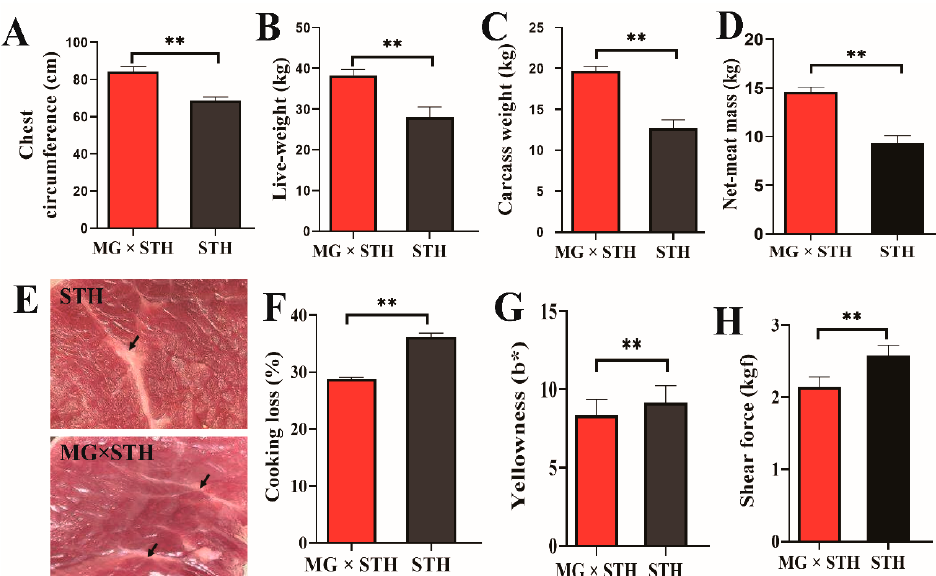
Figure 1. Significantly different indexes related to production performance and meat quality between the Mongolian (MG) × small-tailed Han (STH) sheep and the STH sheep. ( A–D ) The indexes of chest circumference, live weight, carcass weight, and net meat mass used for evaluating the production performance of MG × STH and STH sheep. ( E ) The marbling of MG × STH and STH sheep. The black arrow shows the deposited fat in the marbling. ( F–H ) The indexes of cooking loss, yellowness (b*), and shear force used for assessing the meat quality of the MG × STH and STH sheep. **p < 0.001